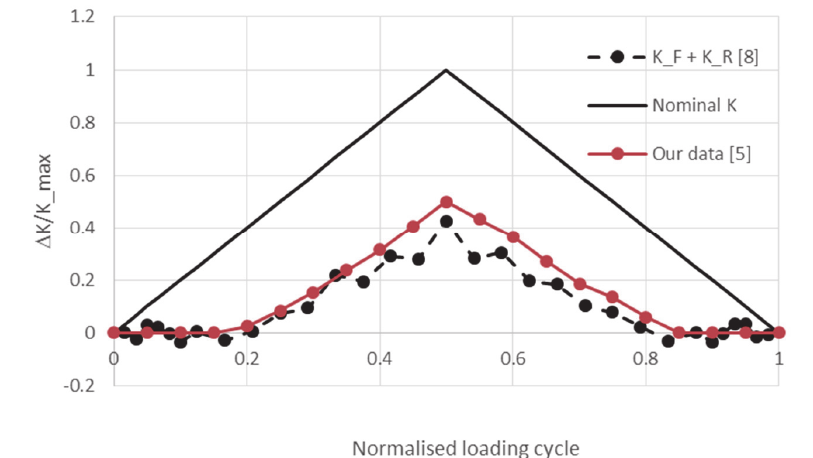
Figure 6: Vasco Olmo’s data [8] plotted as delta K against loading cycle and compared against our own [5] (also shown in Fig.2.)